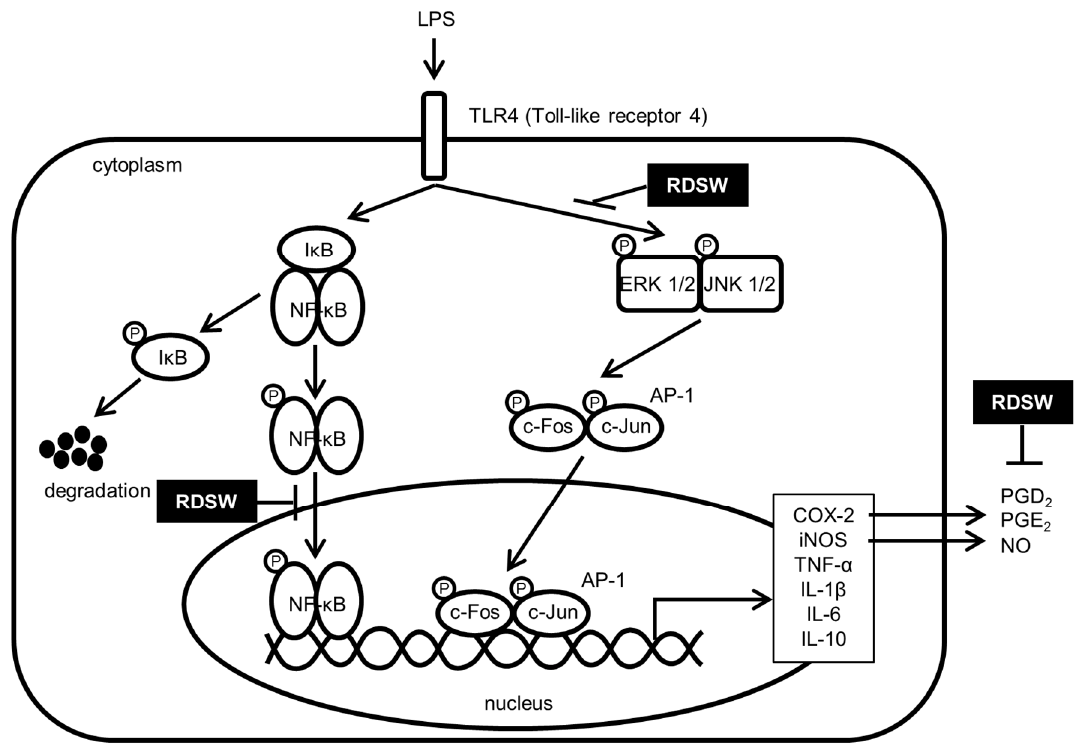
Figure 7. The proposed action mechanism responsible for the suppressive effects of RDSW on the LPS-induced inflammatory signaling pathway. LPS-induced inflammatory signaling